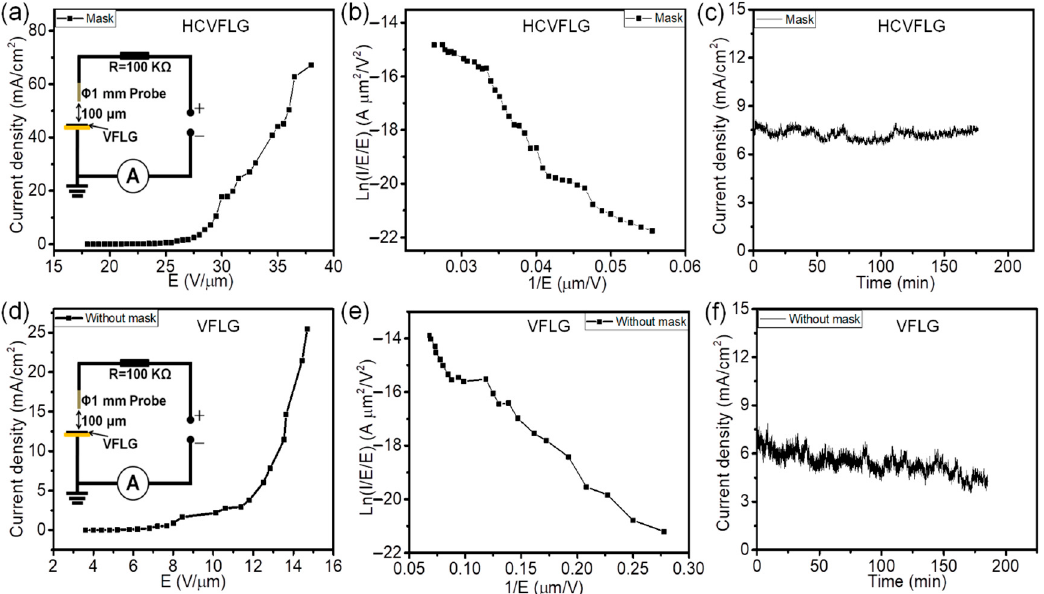
Figure 6. Field emission characteristics of HCVFLG on Cu substrates: ( a ) Field emission I–V curves, ( b ) the corresponding F–N curves, and ( c ) current stability. Field emission characteristics of VFLG grown without mask: ( d ) Field emission I–V curves, ( e ) the corresponding F–N curves, and ( f ) current Nanomaterials 2022 , 12 , x FOR PEER REVIEW 12 of 14 stability. Inset images of ( a ) and ( d ) are schematic circuits of test.